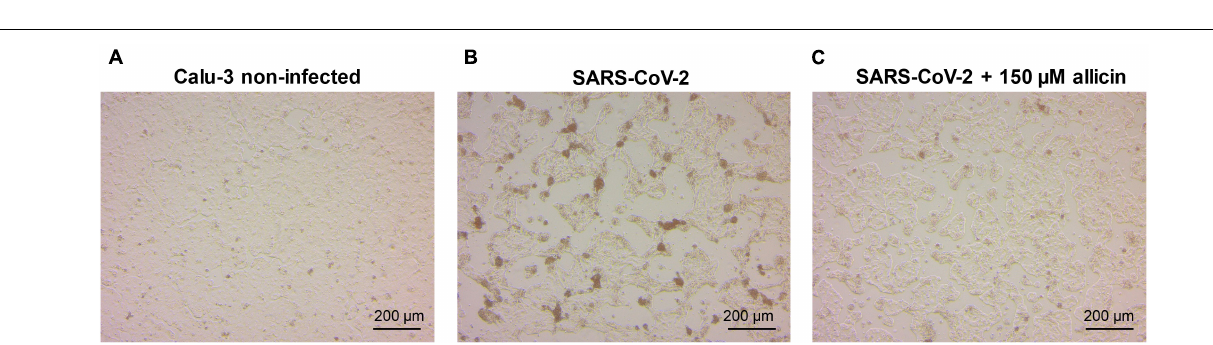
FIGURE 4 | Cellular effect of 150 µ M allicin on SARS-CoV-2 infected Calu-3 cells. Non-infected Calu-3 cells were cultivated for 24 h and served as controls (A) . Calu-3 cells were infected with SARS-CoV-2 at a MOI of 0.01 and the SARS-CoV-2 induced cellular effects were studied at 24 h p.i. without (B) or with 150 µ M allicin treatment (C) after infection as described in the “Materials and Methods” section. At 24 h p.i. infected Calu-3 cells showed cellular damages, including cell rounding, detachment and cell death (B) . Allicin treatment decreased some cellular damages (C) . Cells were imaged with a Nikon Ts2R-FL inverted